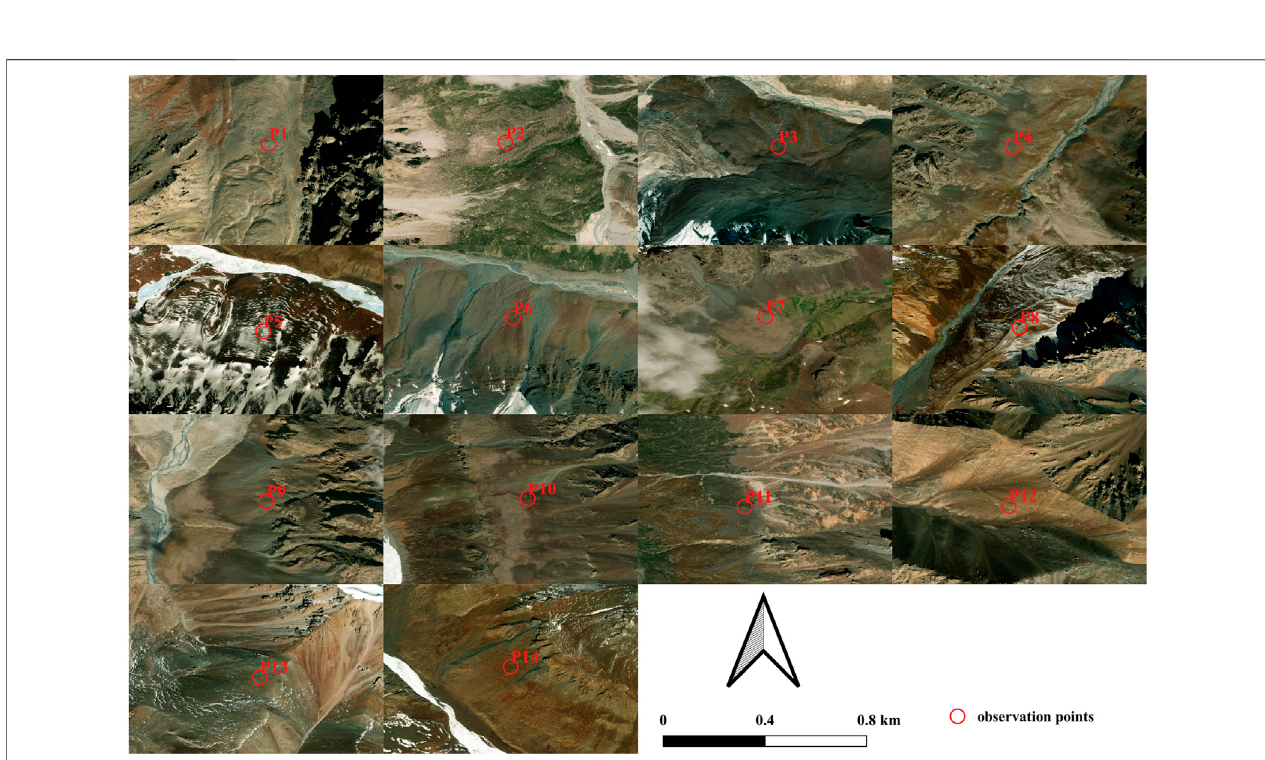
FIGURE 10 | The close-up shots around the observation points based on Esri satellite image maps on a scale of 1:380,000.